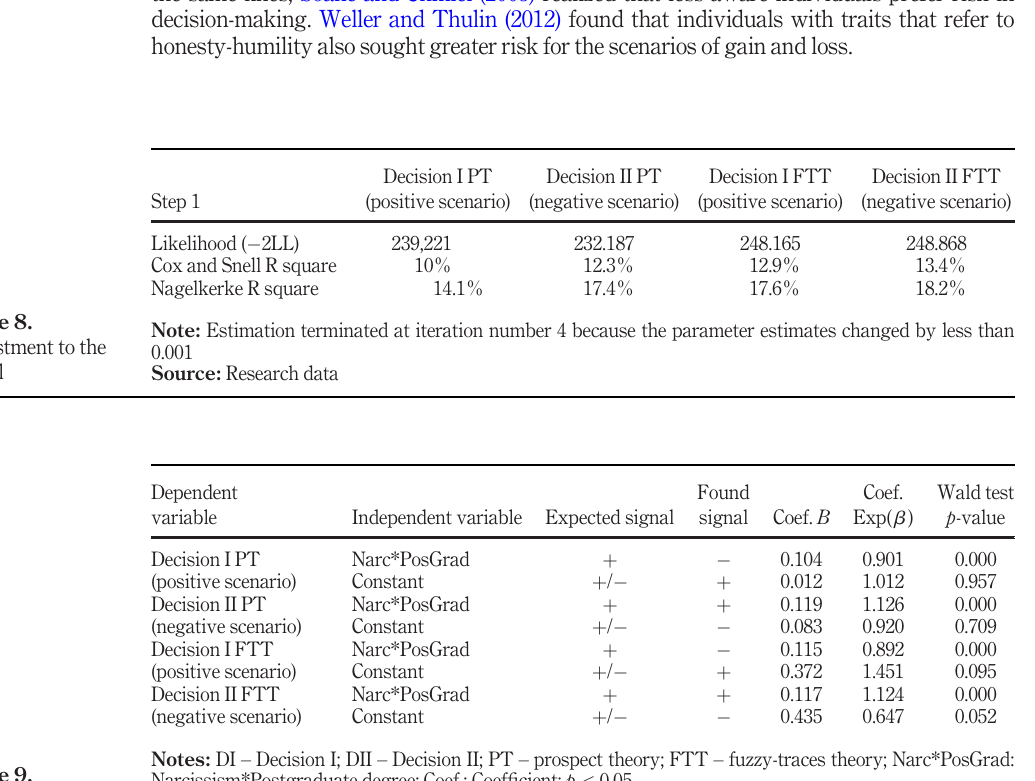
Table 9. Logistic